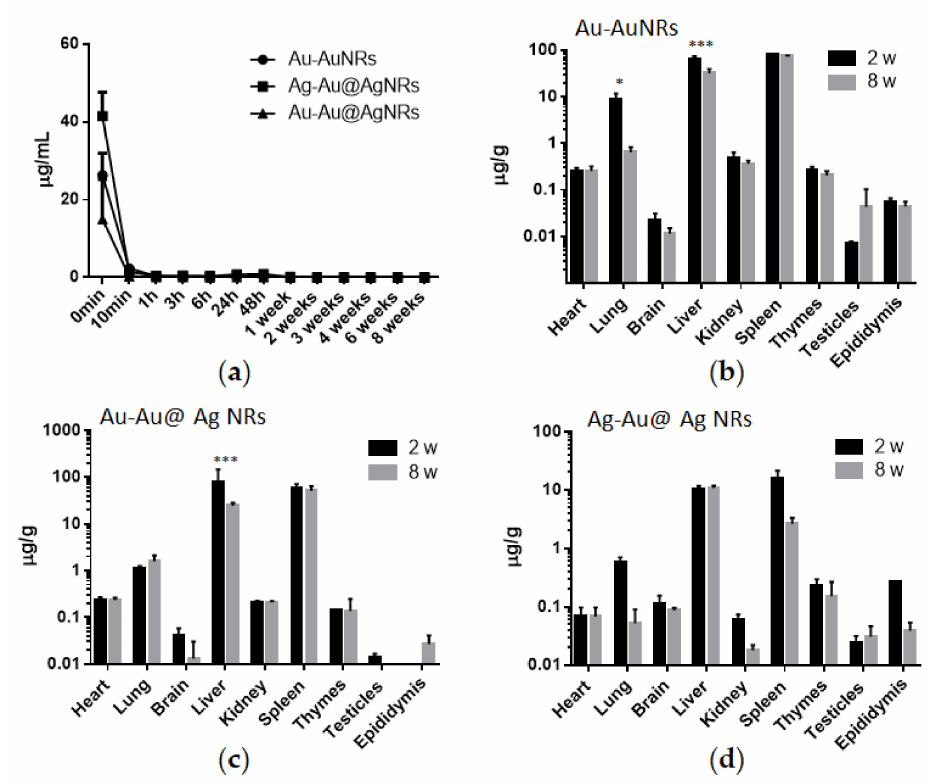
Figure 2. The contents of Au and Ag in tissues after AuNRs or Au@Ag NRs exposure. ( a ) The concentration–time curve in blood for Au or Ag. ( b ) The Au content in organs after the AuNRs exposure. ( c , d ) The content of Au or Ag after the Au@Ag NRs exposure. * p < 0.05; *** p <